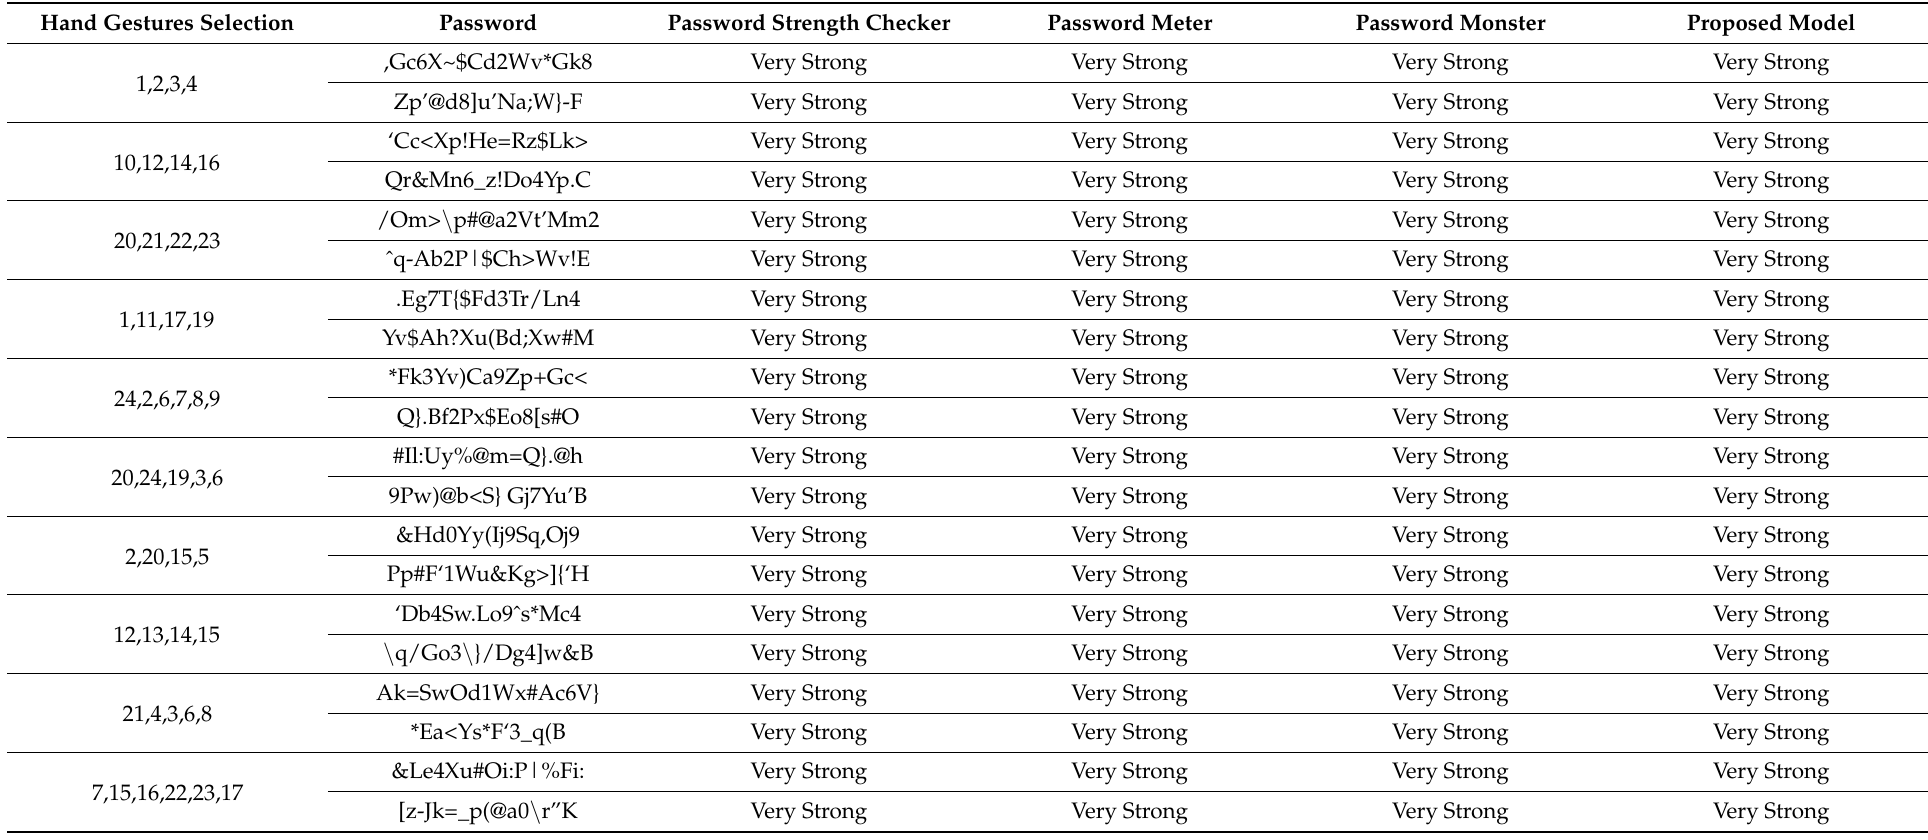
Table 8. The estimation results of generated passwords using different password